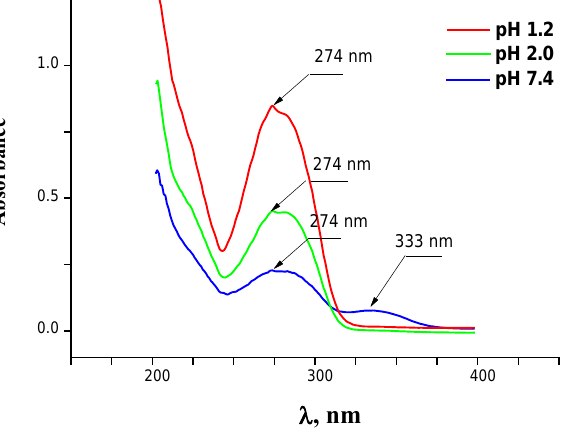
Figure 4. UV–visible absorption spectra of IVZ in buffers solutions (pHs 1.2, 2.0 and Figure 4. UV – visible absorption spectra of IVZ in buffers solutions (рН s 1.2, 2.0 and 7.4).